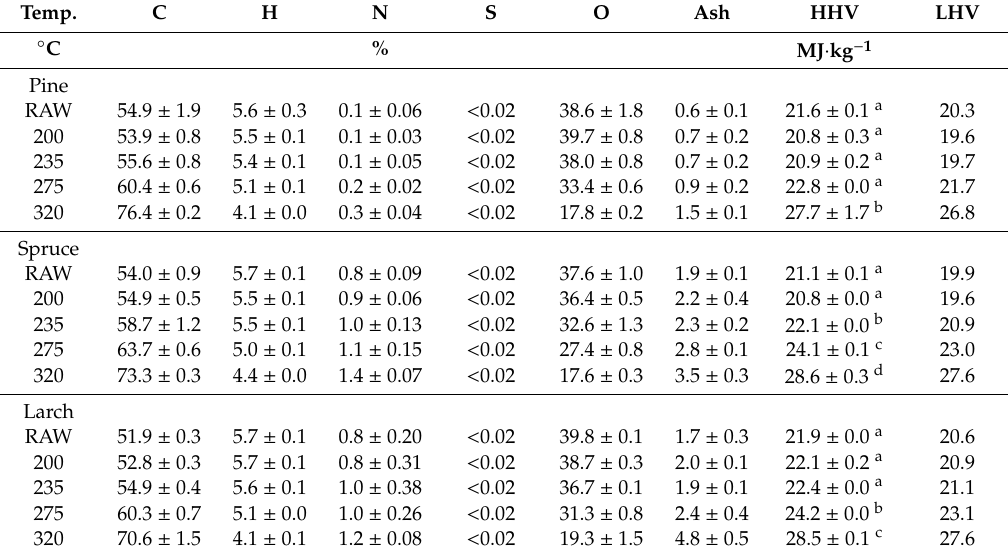
Table 1. Elemental composition, ash content, higher heating value (HHV), and lower heating value (LHV) in dry state.